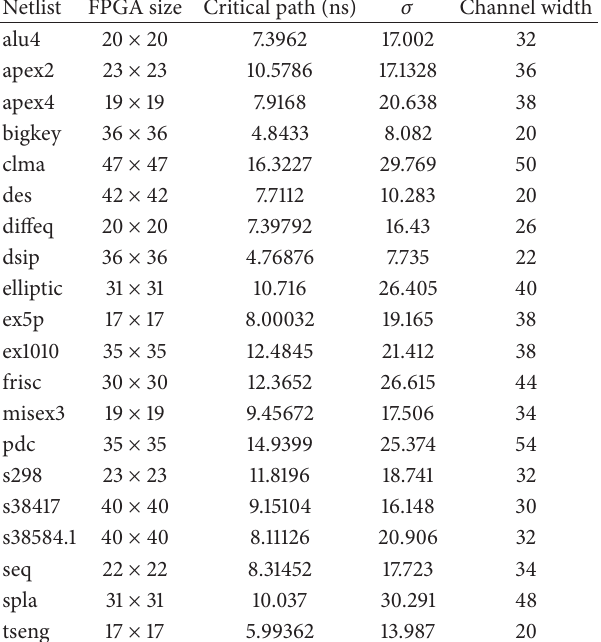
Table 2: Results produced by VPR for cluster size 𝑁 = 4